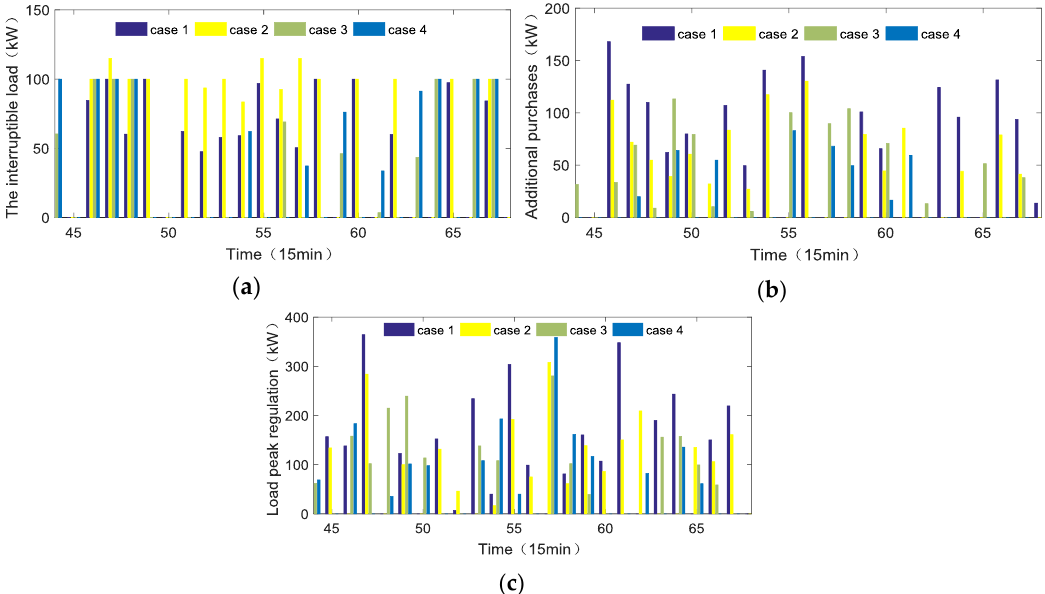
Figure 3. Outputs of the intraday phase from 11:00 to 17:00: ( a ) Interruption of the interruptible load; ( b ) unplanned purchases; ( c ) PLR.